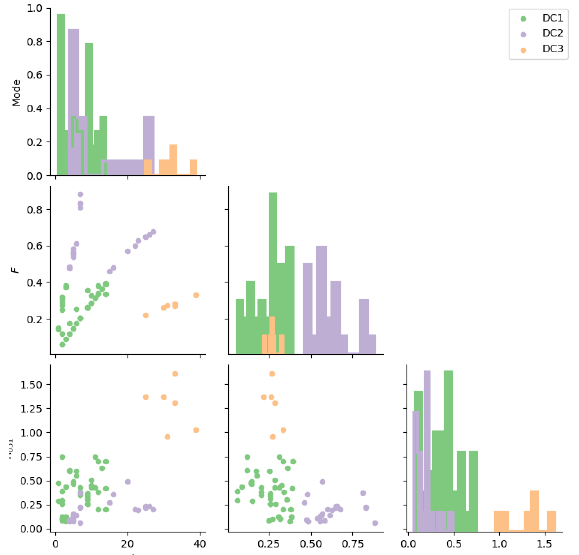
Figure 8. The result of spectral clustering for three clusters in the same parameter space as for Figure 6. The three algorithms agree on the small high-mode cluster and also on the main structure of the remaining two clusters, but not the exact distribution of the data points. The Gaussian mixture allows for larger overlap between the clusters than the spectral clustering.